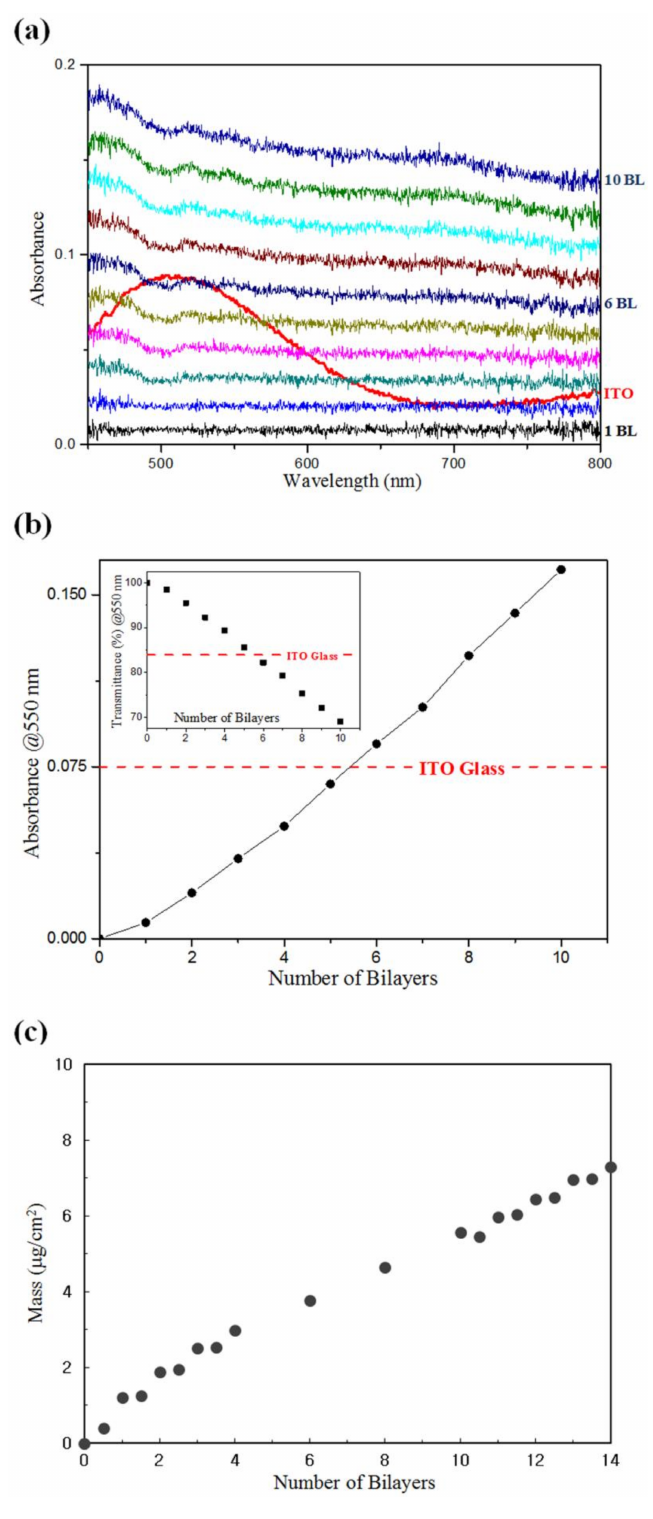
Figure 3. ( a ) UV–Visible (UV–Vis) absorbance spectra of [PDDA/(SWNT–DOC)] n ( n = 1–10) thin films and an indium tin oxide (ITO) coating from 450 to 800 nm wavelength. ( b ) Light absorbance and transmittance (inset) of 1–10 bilayers (BLs) at 550 nm wavelength. ( c ) Mass growth of a [PDDA/(SWNT–DOC)] system up to 14 BLs (half BL:PDDA